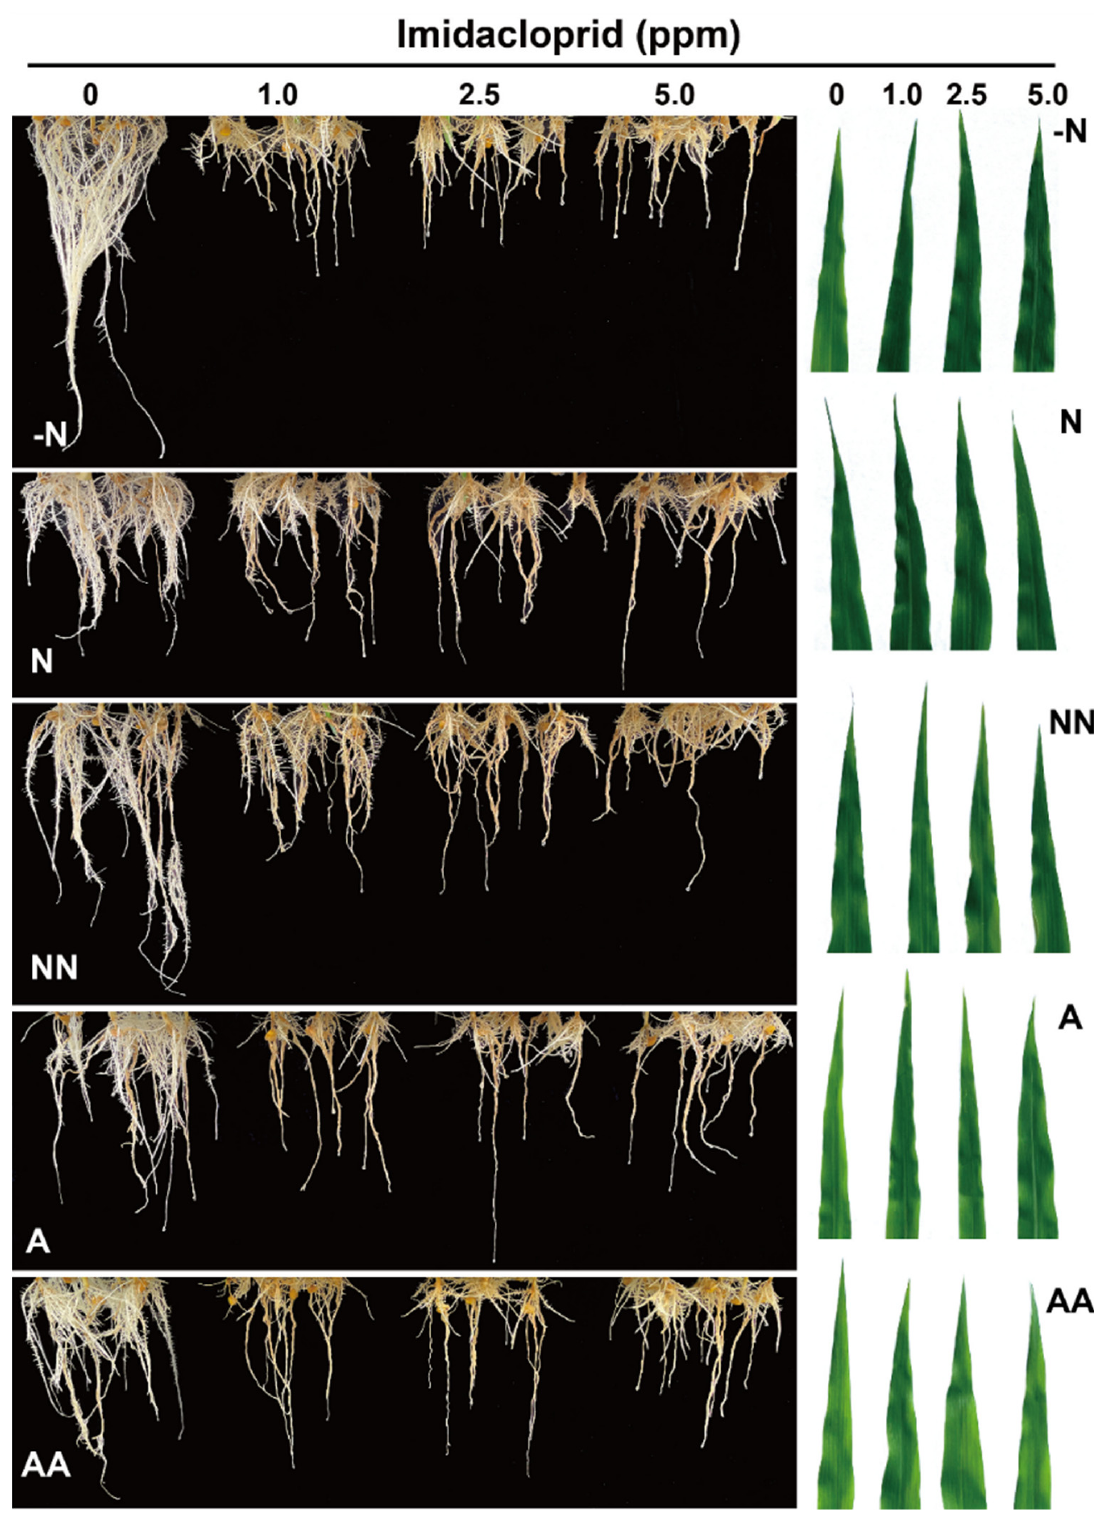
Figure 1. Phenotype of maize under IMI treatment. Phenotype of maize seedlings cultured in modified Hoagland nutrient solution ( − N: no nitrogen supply, N: 4 mmol L − 1 NO 3 − , NN: 10 mmol L − 1 NO 3 − , A: 4 mmol L − 1 NH 4+ and AA: 10 mmol L − 1 NH 4+ ) containing 0, 1, 2.5 or 5 ppm IMI for 14 days.